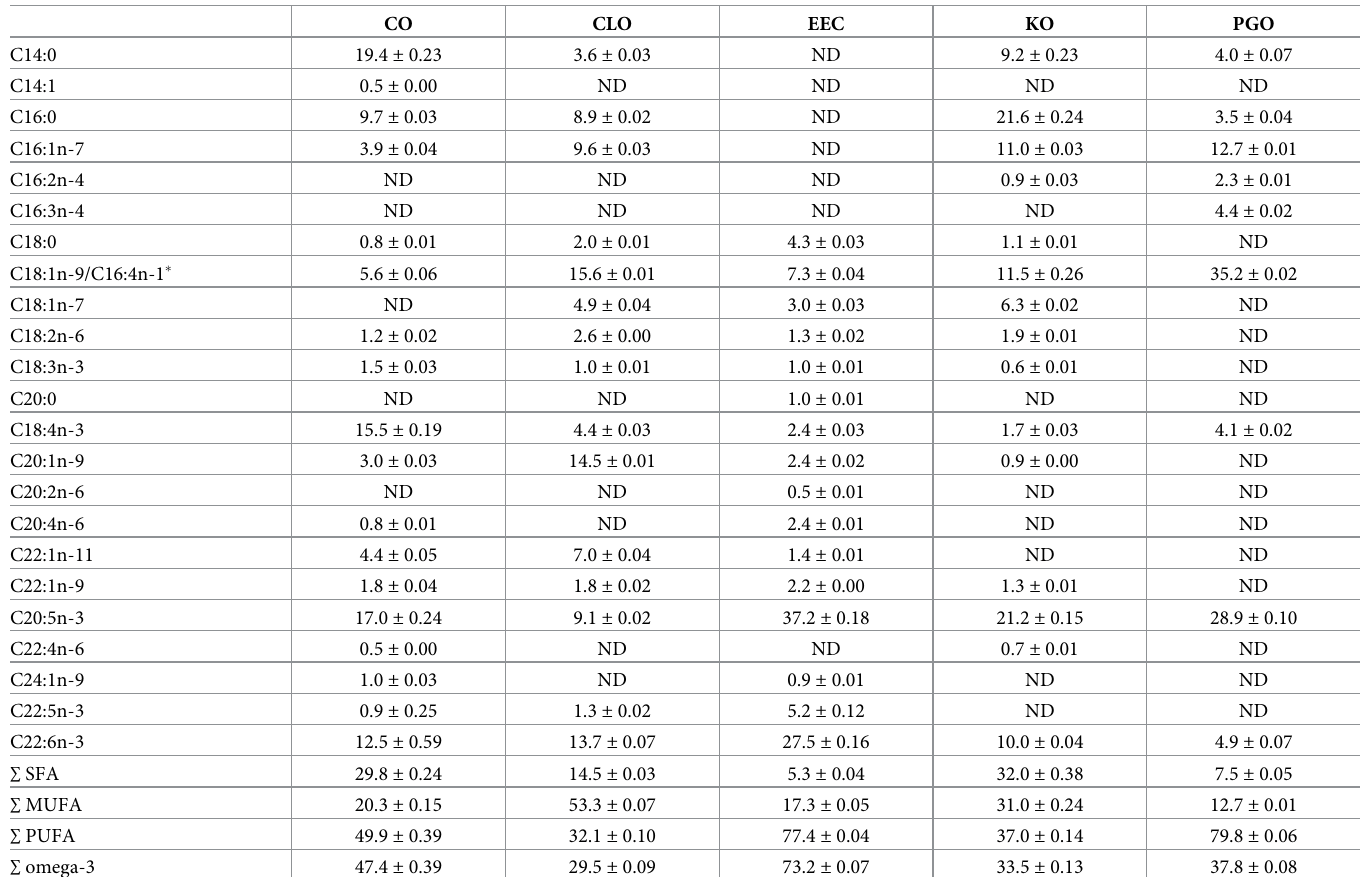
Table 1. Fatty acid composition (weight percent) of Calanus oil (CO), Cod liver oil (CLO), Ethyl ester concentrate (EEC), Krill oil (KO), and oil from Porosira gla- cialis (PGO) (n = 3).